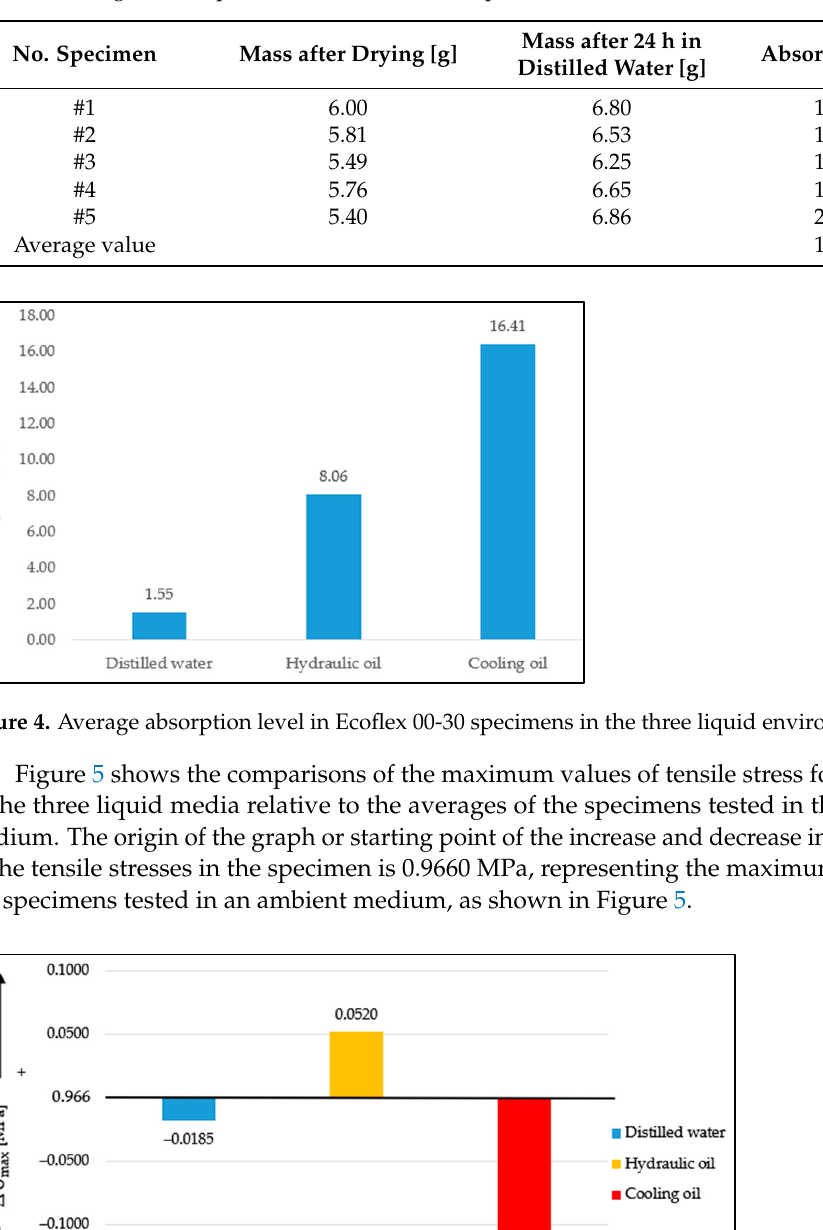
Figure 6. Comparison of the average maximum values of tensile stress for Ecoflex 00-10 specimens for each liquid medium. It can be observed that in the case of distilled water, at an absorption of 1.55%, the maximum tensile strain, at which the specimen breaks, increases by the absolute value of 2.257. In the case of hydraulic oil, at an absorption of 8.06%, the maximum tensile strain increases by the absolute value of 0.3335, and, in the case of cooling oil, at an absorption of 16.41%, the maximum value of the tensile strain shows a decrease of 1.5201. It can be concluded that there is not necessarily a correlation between the level or amount of liquid absorbed by the specimen/material and the increase/decrease in tensile stress/tensile strain, but rather the influence of chemical factors in the external liquid en- vironment on the mechanical and elastic properties of the material. 3.2. Results Obtained for Ecoflex 00-10